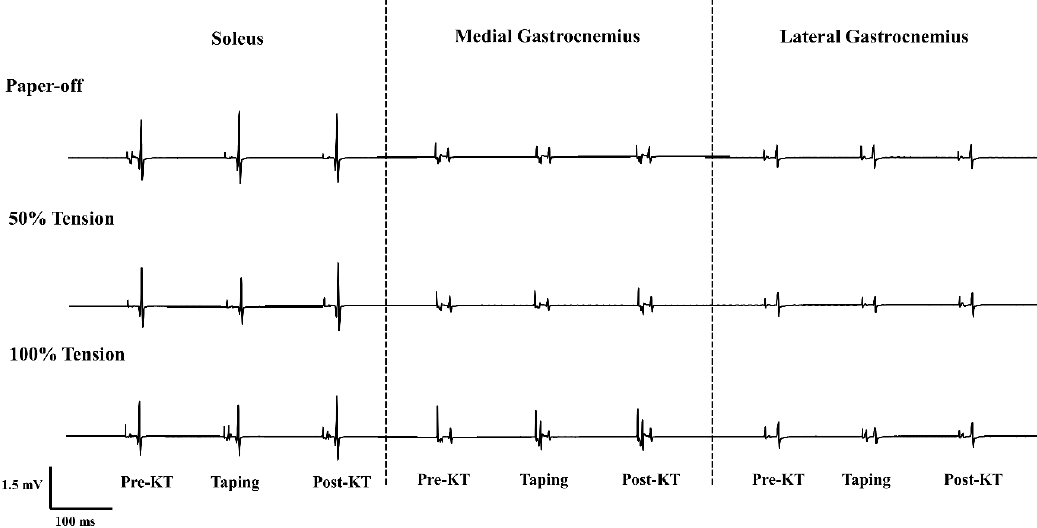
Figure 2. Raw electromyograph of the soleus, medial and lateral gastrocnemius H-reflex from one representative participant in paper-off, 50%KT max , and 100%KT max conditions.